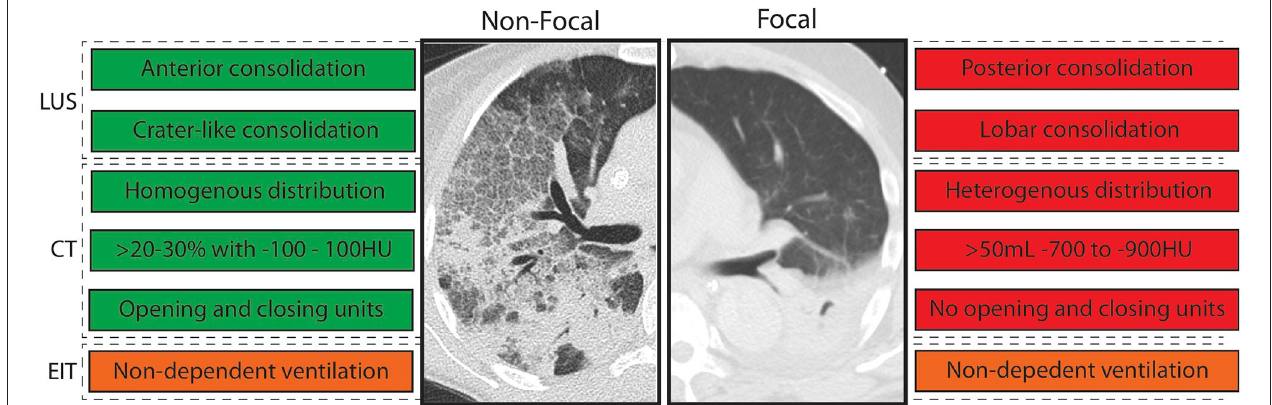
FIGURE 3 | Imaging abnormalities that predicted response to recruitment maneuvers (RM) stratified per morphology. LUS, lung ultrasound; EIT, electrical impedance tomography; CT, computed tomography; HU, Houndsfield units; green, imaging abnormality in line with responder to RM; red, imaging abnormality in line with non-responder to RM; orange, imaging abnormality in line with responder with high uncertainty. Text boxes on the left: consistent with non-focal morphology. Text boxes on the right: consistent with focal